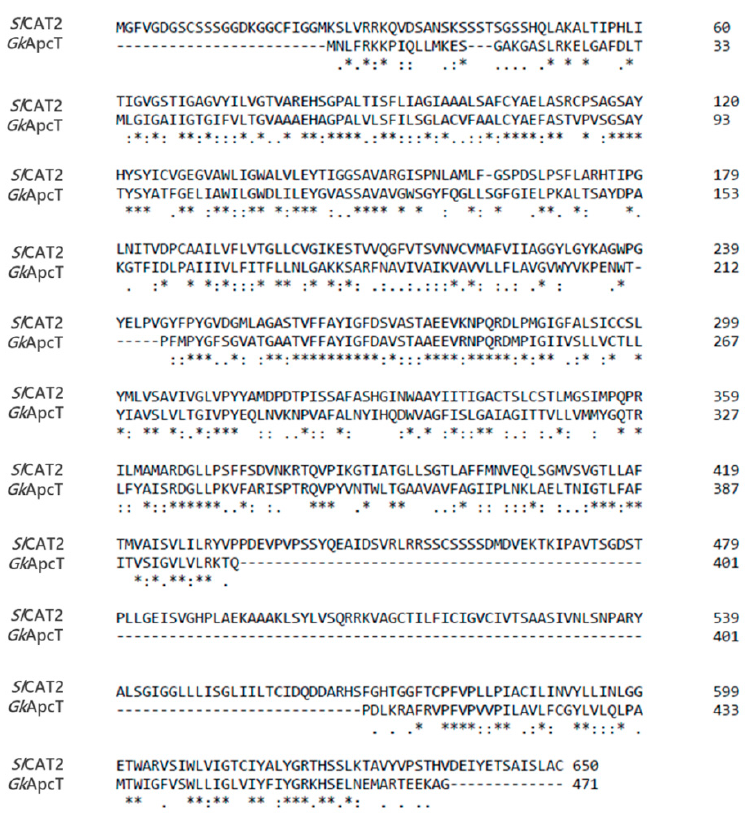
Figure 11. The sequences of Sl CAT2 and Gk ApcT were aligned using the software Clustal Omega as described in Section 4.7.